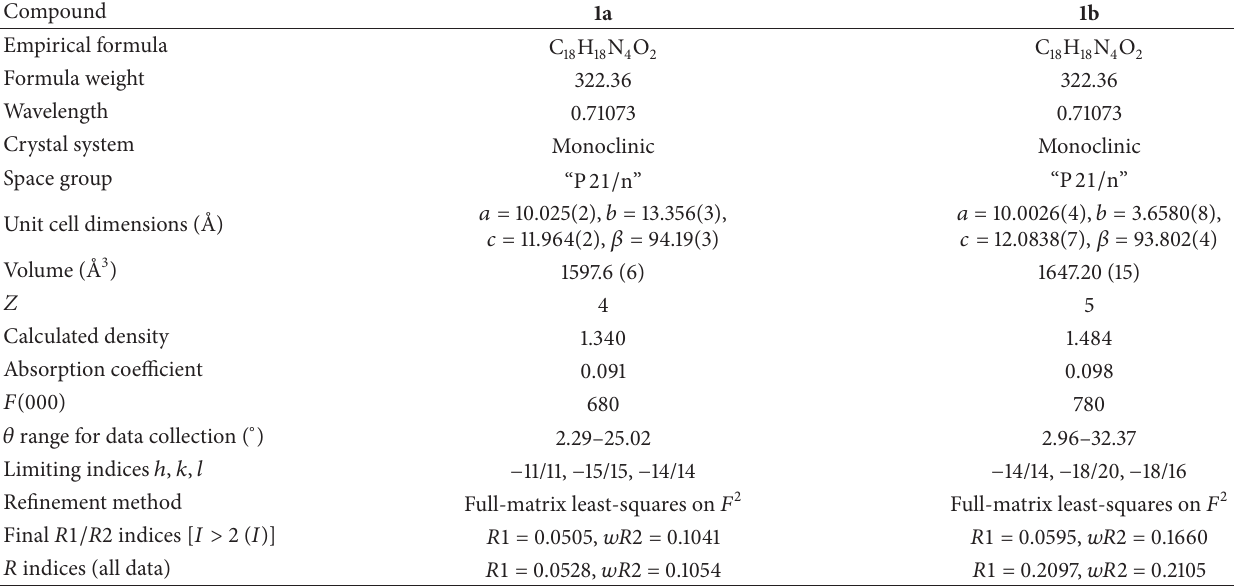
Table 1: Crystal data and structure refinement for polymorphs 1a and 1b